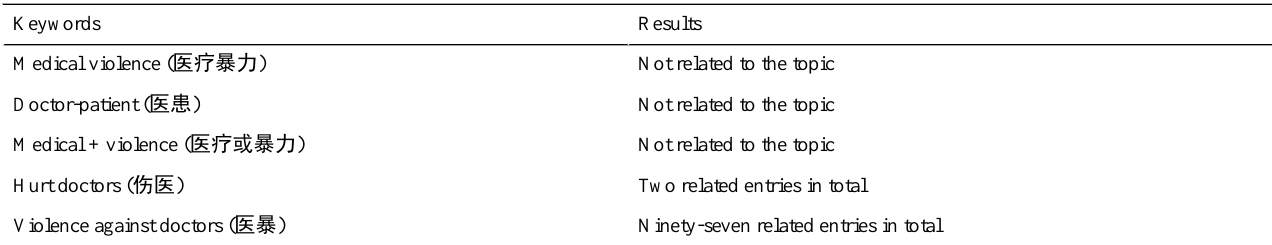
Table 5. Retrieval results from the “ipolicy” system.